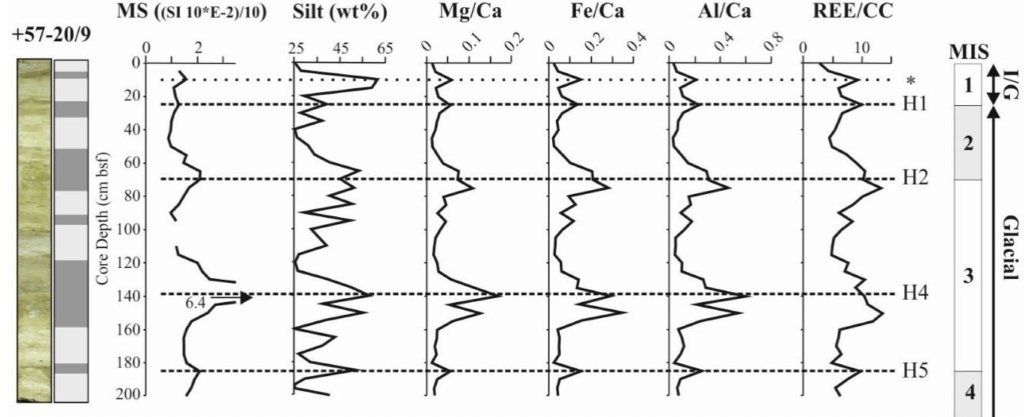
Figure 5. Inferred position of Heinrich events (dashed lines) based on the main proxies and sediment facies for Core + 57-20 / 9. The ash layer (*) is also highlighted (dotted line). The events are marked in the centre of the layers and do not cover the entire layer thickness. From left to right: photograph next to the interpreted sketch based on the two facies described in this study (F1: calcareous ooze (light grey) and F2: lithogenous silt (dark grey)) and depth profiles of proxies studied. (I / G, Interglacial / Glacial transition).